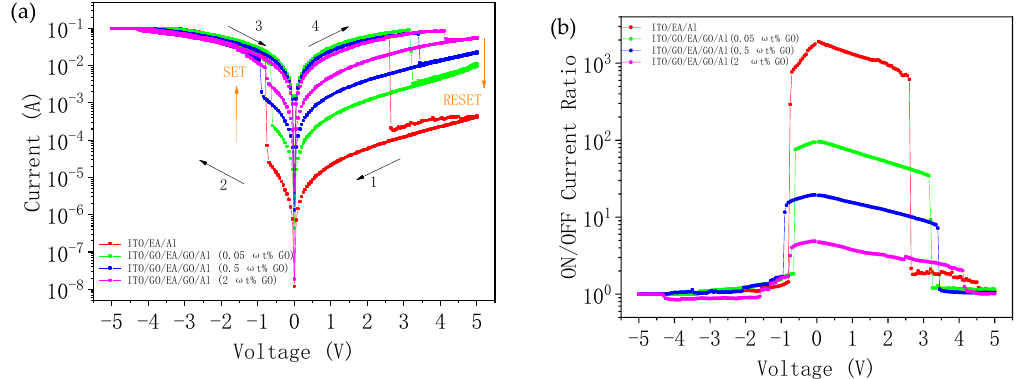
Figure 8. ( a ) I-V characteristics of ITO/EA/Al and ITO/GO/EA/GO/Al devices. ( b ) ON/OFF current ratios of ITO/EA/Al and ITO/GO/EA/GO/Al devices.